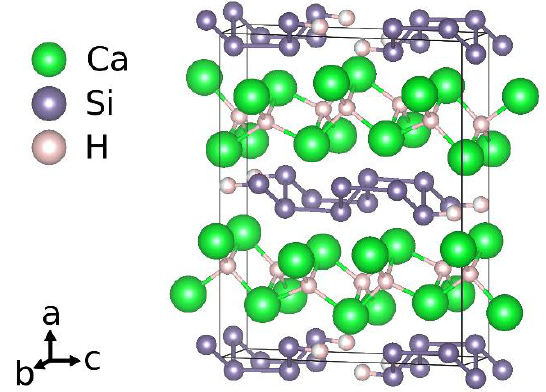
Figure 1. Crystal structure according to an idealized chemical formula CaSiH 4 / 3